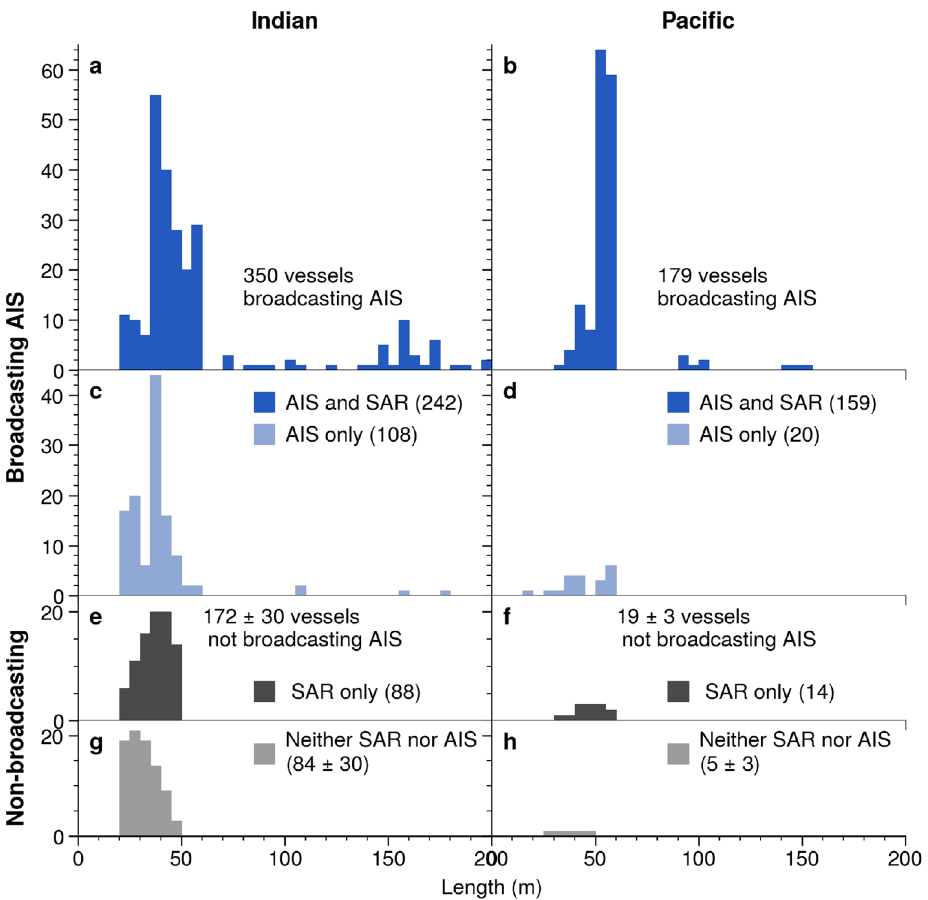
Figure 4. Vessels are detected by AIS, SAR, both, and neither. ( a , b ) SAR detections that matched to AIS in the Indian and Pacific regions. ( c , d ) Vessels broadcasting AIS in each region that were likely within the image footprints but not detected by SAR. ( e , f ) Unmatched SAR detections, representing non-broadcasting vessels. ( g , h ) The most likely distribution of vessels detected by neither SAR nor